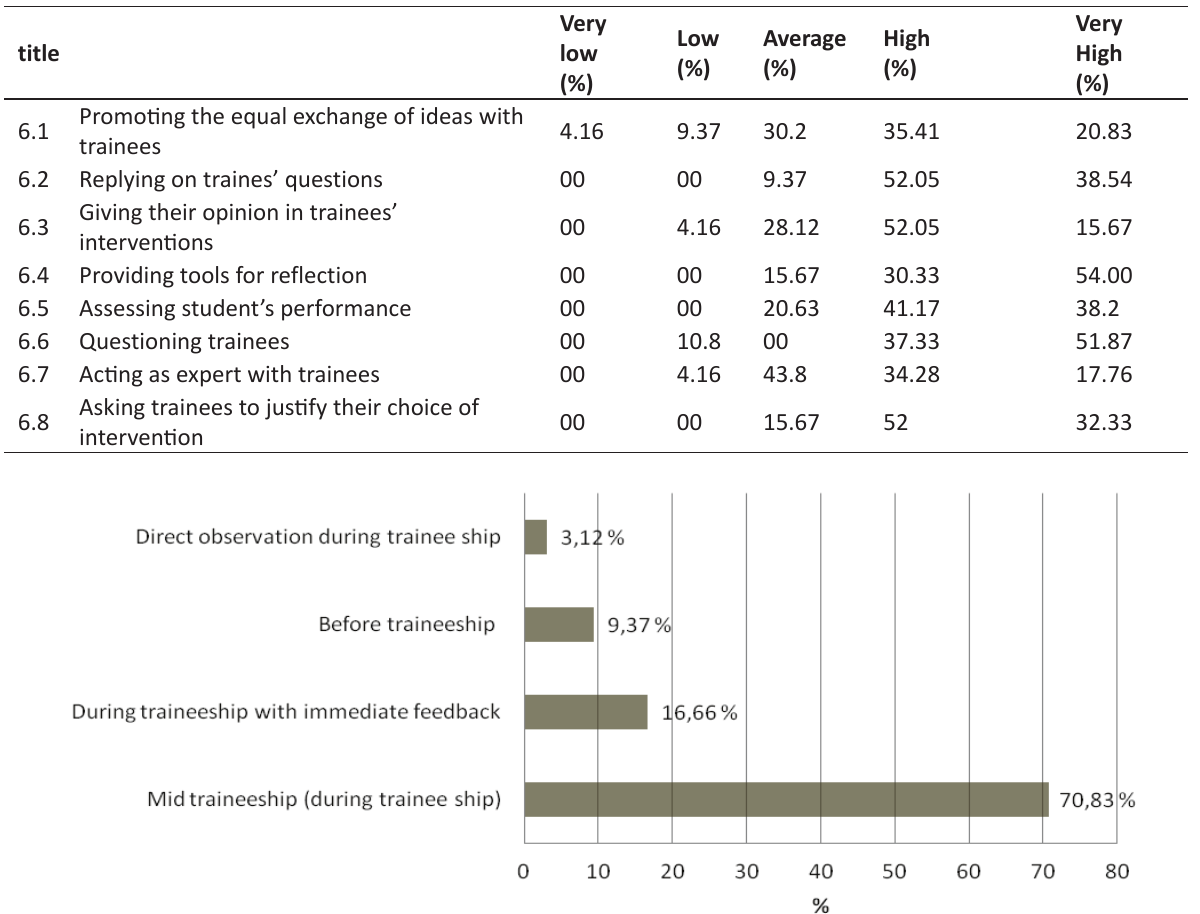
Table 4 . Impact of CT practices on developing trainees’ skills